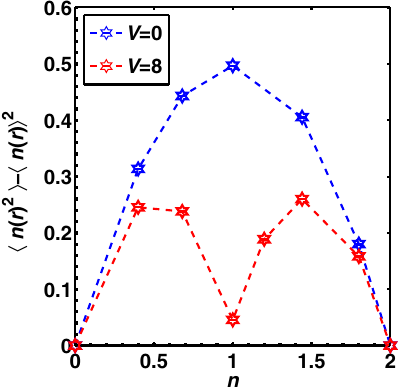
k Þ ( 0 ≤ k ≤ π ) at FIG. 5. The momentum space distribution n F ð β ¼ 10 and n ¼ 1 , and n k Þ of the noninteracting spinless F ð fermion (red dashed line) is plotted for comparison. The system size L ¼ 50 . The parameter values are V ¼ 0 and J ¼ 2 . The error bars of the QMC data are smaller than the